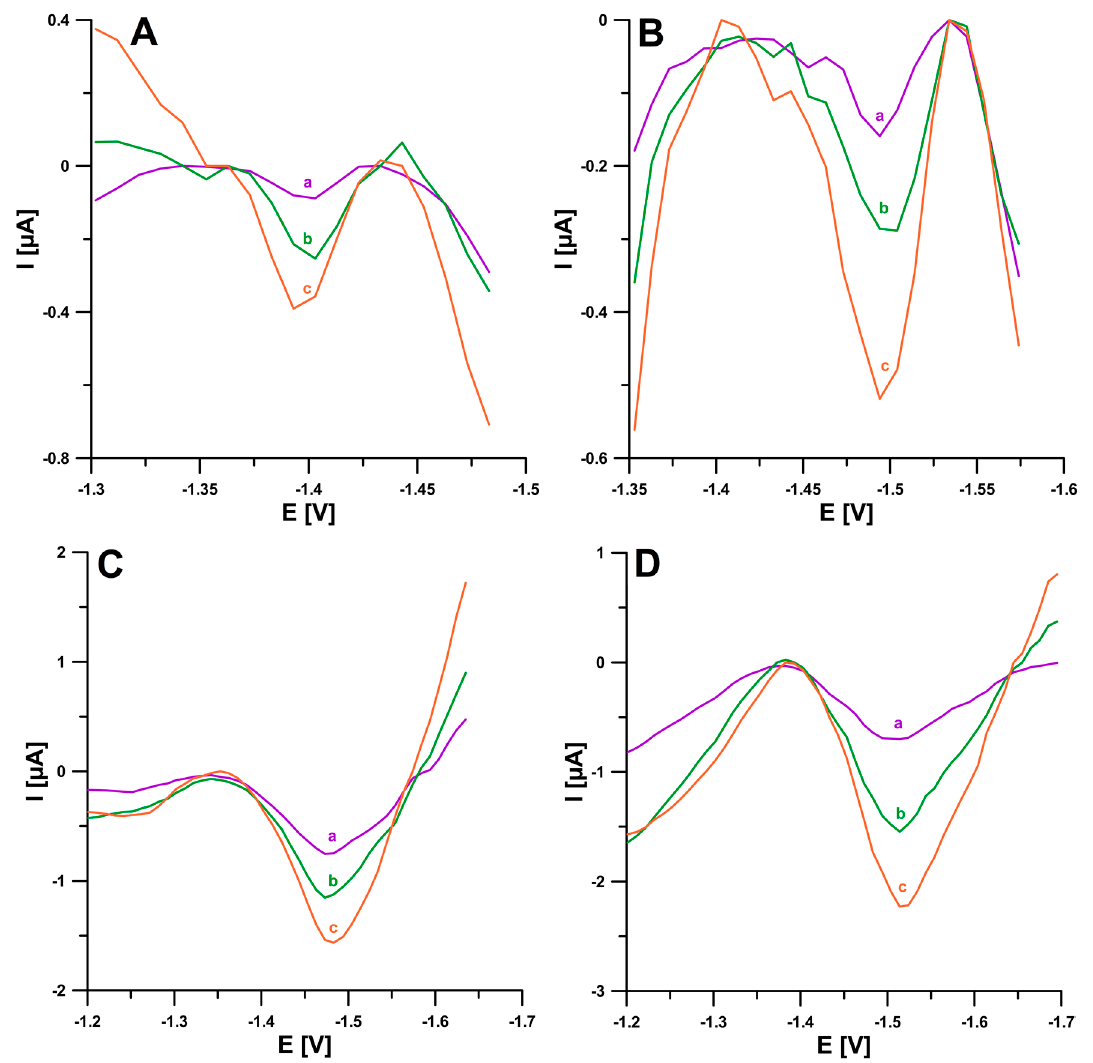
Figure 9. Voltammograms recorded for the determination of BLM in reference material of human urine ( A , B ) and wastewater samples purified in a sewage treatment plant ( C , D ). ( A ): (a) 1 µ L of sample + 2, (b) as (a) + 2, (c) as (a) + 4 nM BLM, ( B ): (a) 1 µ L of sample + 4, (b) as (a) + 4 (c) as (a) + 8 nM BLM, ( C ): (a) 1 mL of sample + 0.5, (b) as (a) + 0.5, (c) as (a) + 1 nM BLM, and ( D ): (a) 1 mL of sample + 2, (b) as (a) + 2, (c) as (a) + 4 nM BLM. E acc. = − 1.0 V, t acc. = 120 s, f = 50 Hz, E SW = 50 mV, and ∆ E = 10